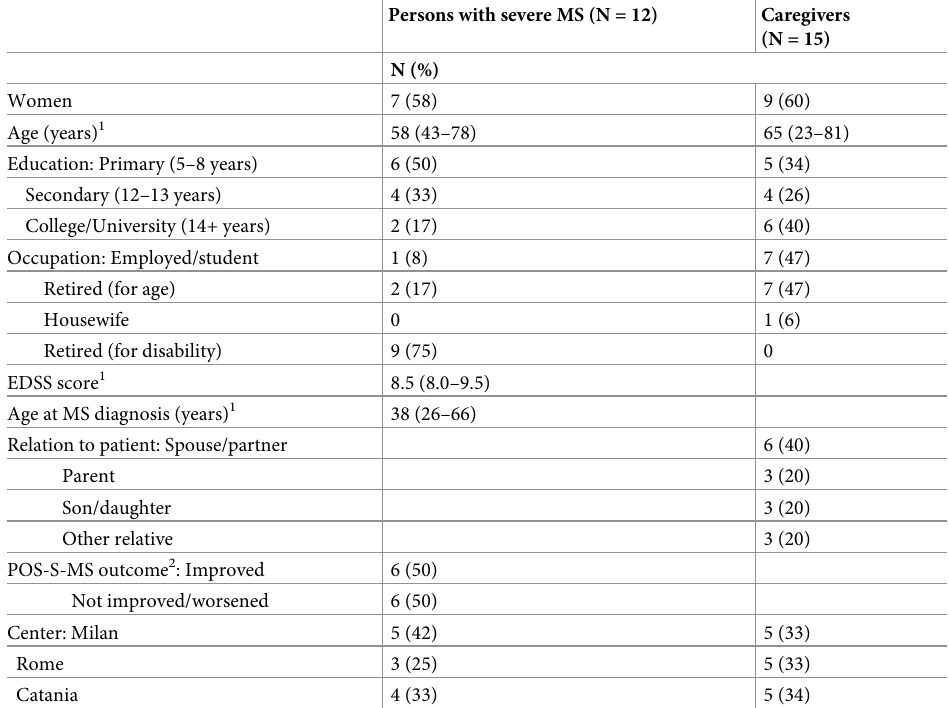
Table 1. Characteristics of participants of personal semi-structured